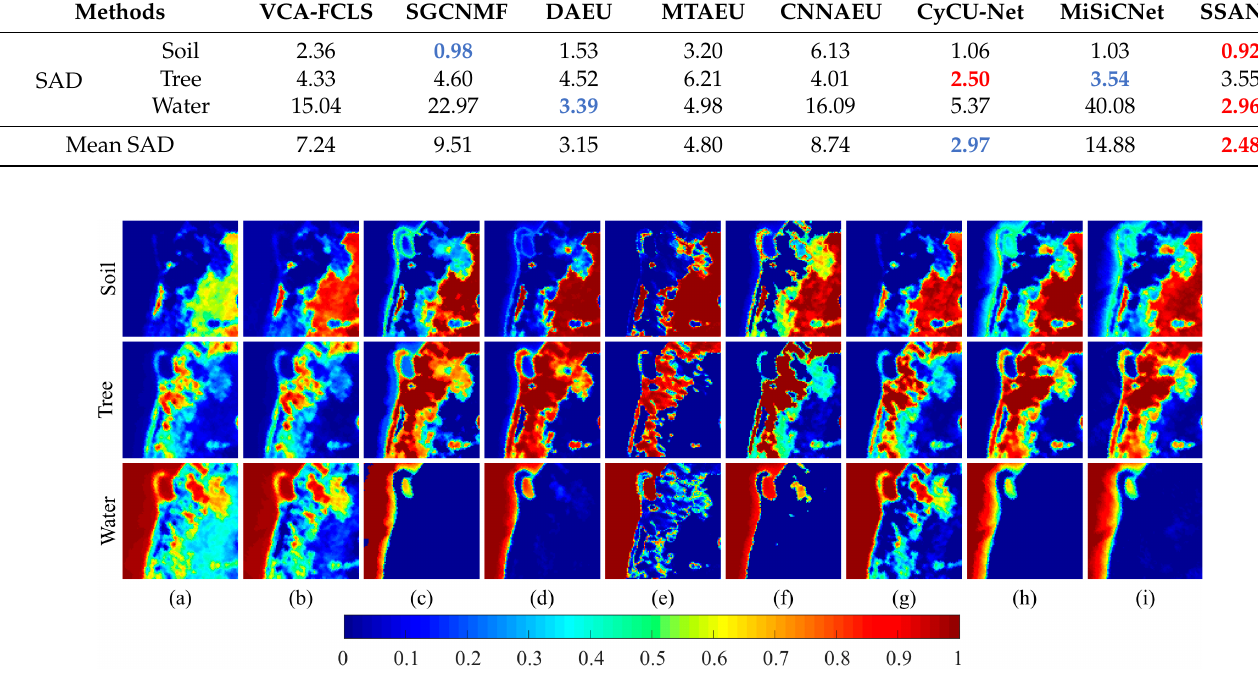
Figure 11. Visualization results of the abundances of Samson data. ( a ) VCA-FCLS. ( b ) SGCNMF. ( c ) DAEU. ( d ) MTAEU. ( e ) CNNAEU. ( f ) CyCU-Net. ( g ) MiSiCNet. ( h ) SSANet. ( i ) GT.